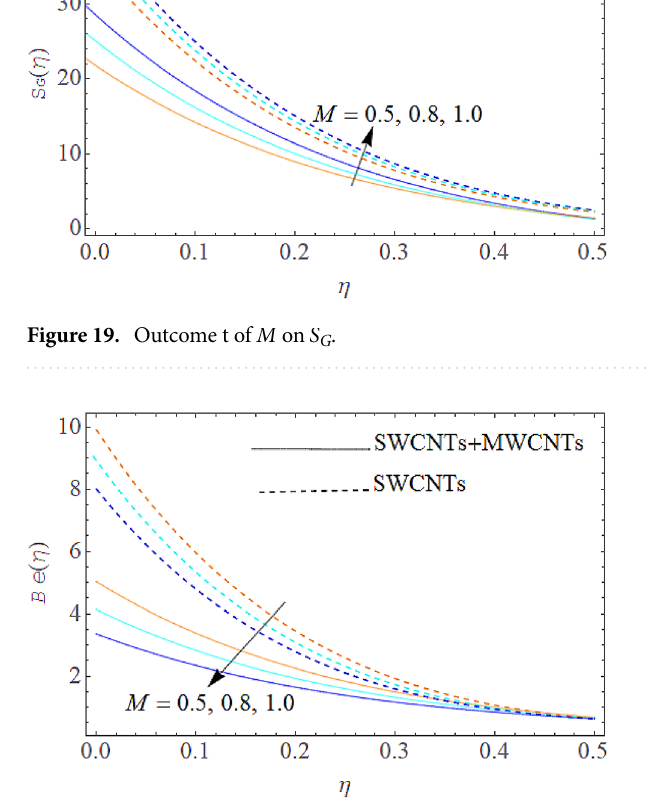
Figure 20. Influence of M on Be .